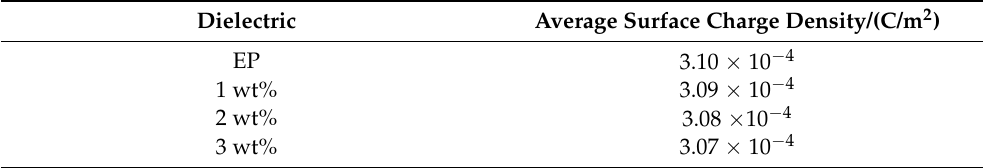
Table 8. The average surface space charge density of pure epoxy resin and SiO 2 /epoxy resin nano-